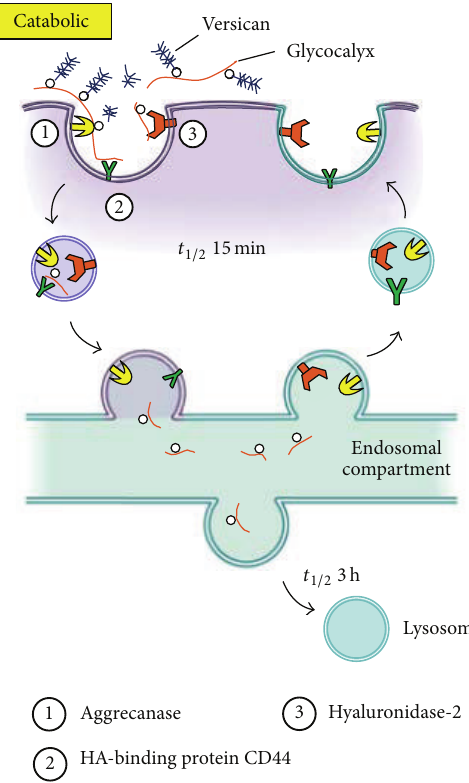
Figure 4: Model for catabolism of pericellular hyaluronan glyco- calyx matrices (adapted from [86] with the permission from Dr.